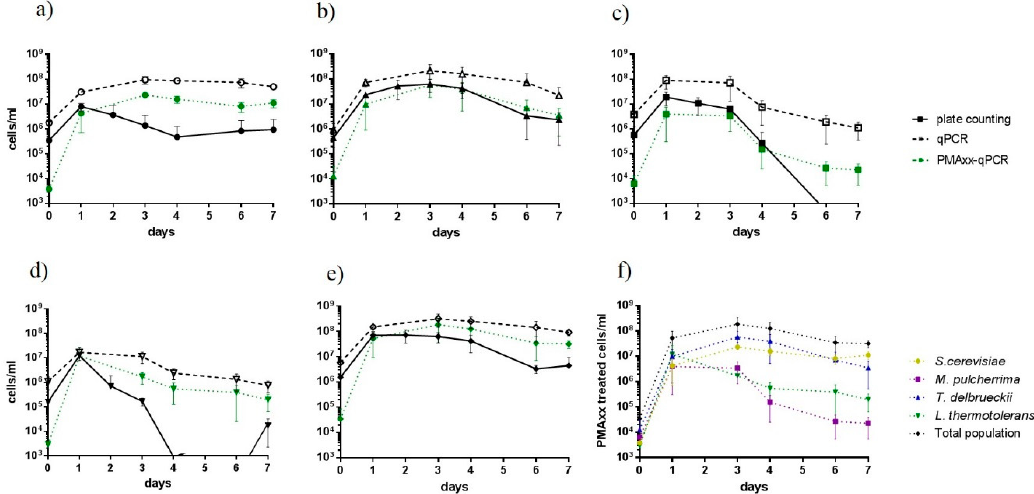
Figure 3. Yeast population analysis based on colony counting performed with WLN plates (black lines) and qPCR with or without PMAxx treatment (green dotted lines or black dashed lines, respectively) of ( a ) S. cerevisiae , ( b ) T. delbrueckii , ( c ) M. pulcherrima , ( d ), L. thermotolerans and ( e ) and total yeast population during fermentation. ( f ) Growth dynamics of the different yeast species based on PMAxx-qPCR results.